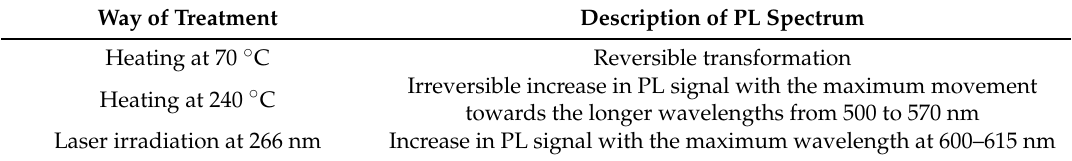
Table 3. Features of the photoluminescence (PL) spectra related to the Cd(C 12 H 25 S) 2 powder treatment.